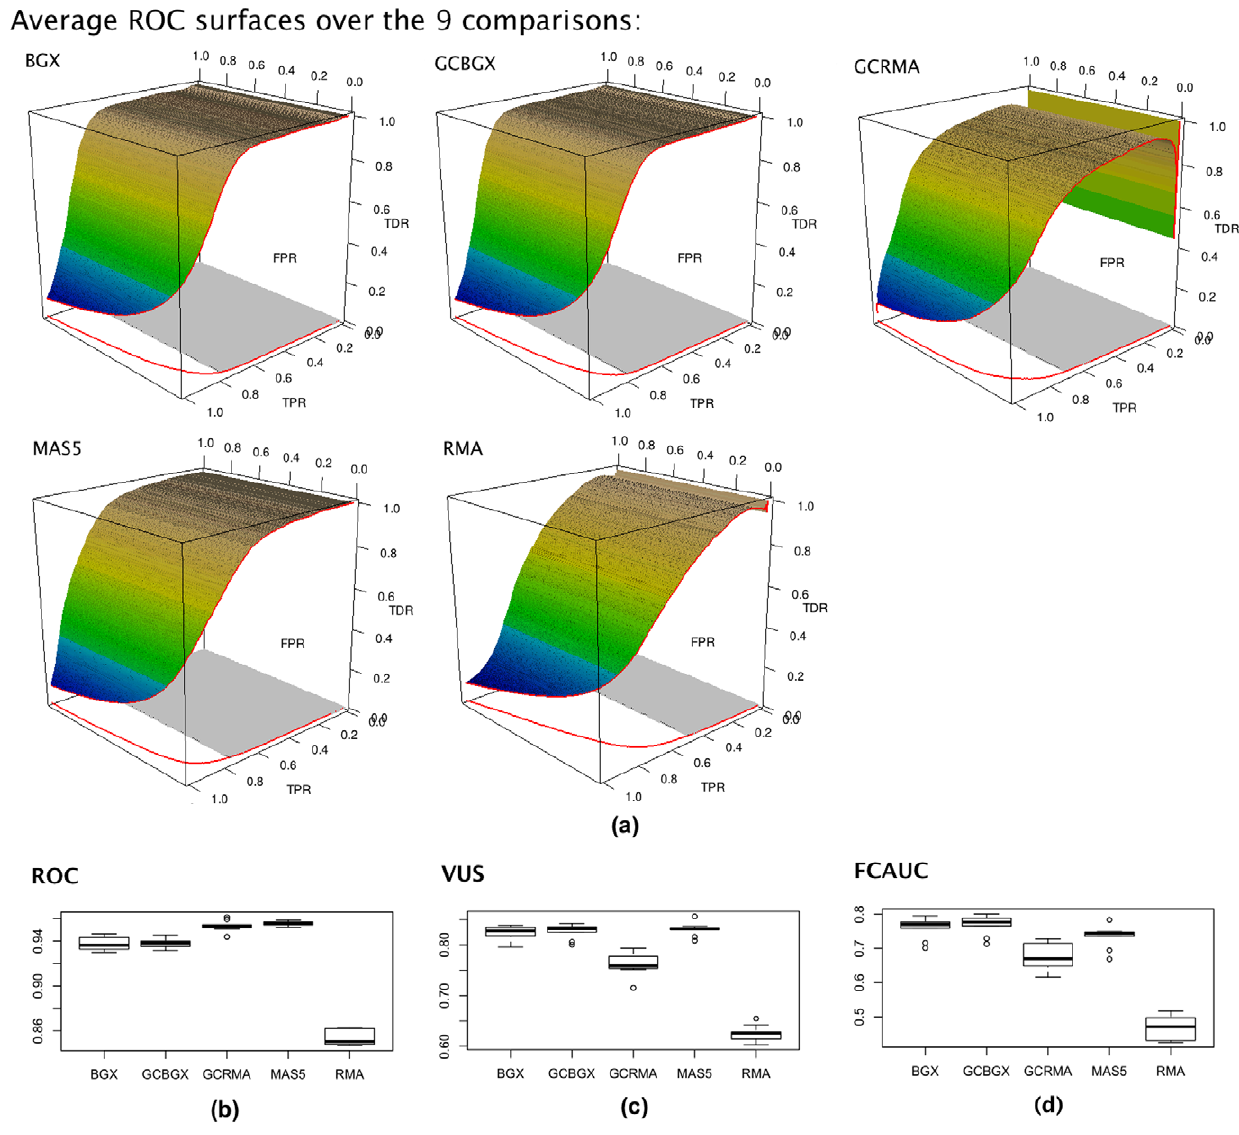
Figure 5. Illustration of the ROCS procedure using the results on the golden spike dataset [ 5 ] by Turro et al [ 10 ] . (a) ROCS plots of the results. (b) Comparing the regular AUC under ROC of the nine single array pairs. (c) Comparing the VUS values of the nine single array pairs. (d) Comparing the FCAUC values of the nine single array pairs. Please note that the nine comparisons in Turro et al [10] are not independent. Thus the distributions in (b), (c) and (d) only serve to illustrate the values. They do not have any implications of significant differences between methods.